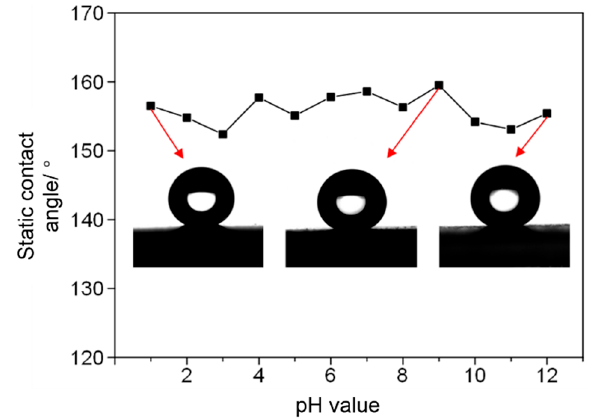
Figure 3. Static contact angle of super-hydrophobic methyl silicone resin/SiO 2 composite coating after infiltrating with corrosive liquids with different pH values for 24 h.